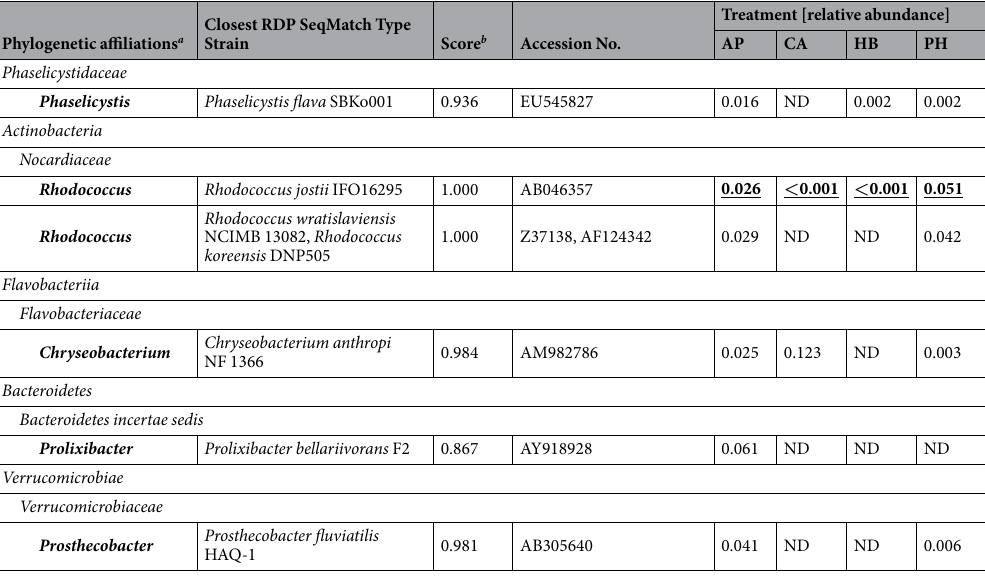
Table 1. Phylogenetic affiliation of the thirty most abundant enriched bacterial sequence variants. a Phylogenetic affiliations are based on Ribosomal Database Project (RDP) Classifier. b Similarity reports the percent sequence identity over all pairwise comparable positions. ND: Not